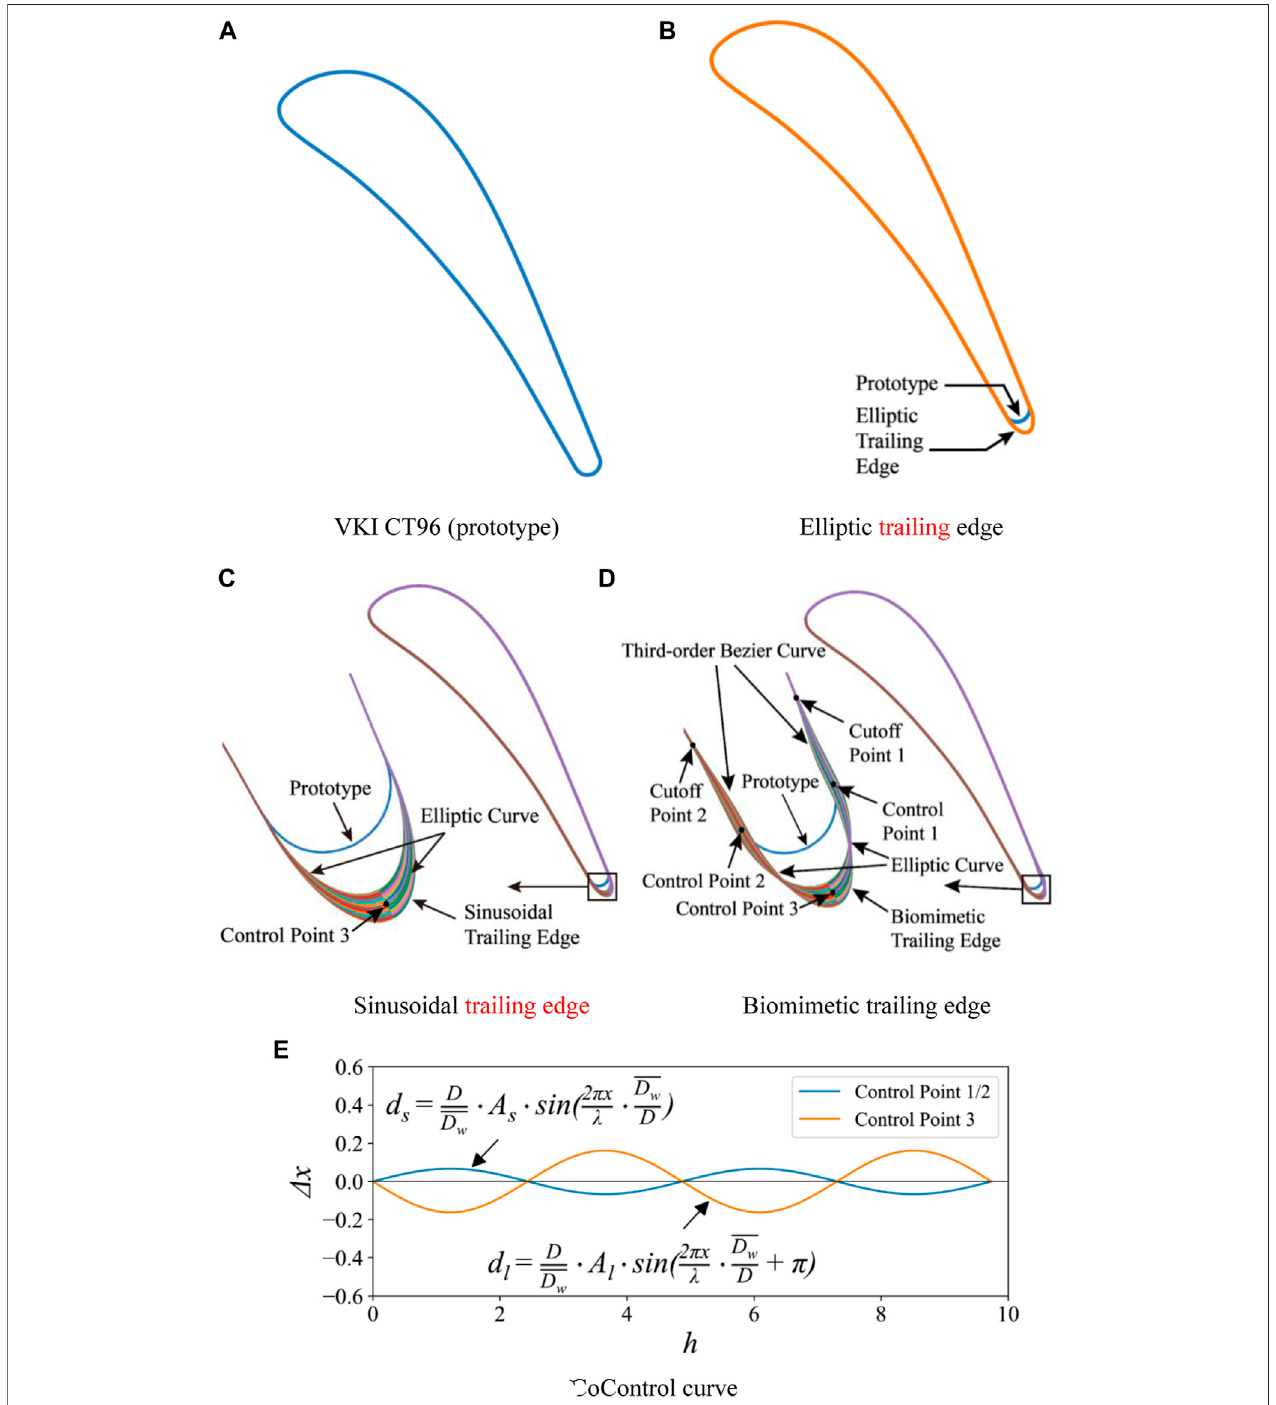
FIGURE 1 | The pro fi les of the four cases and the generation method of the biomimetic blade. (A) VKI CT96 (prototype) (B) Elliptic trailing edge. (C) Sinusoidal trailing edge (D) Biomimetic trailing edge. (E) Control curve.